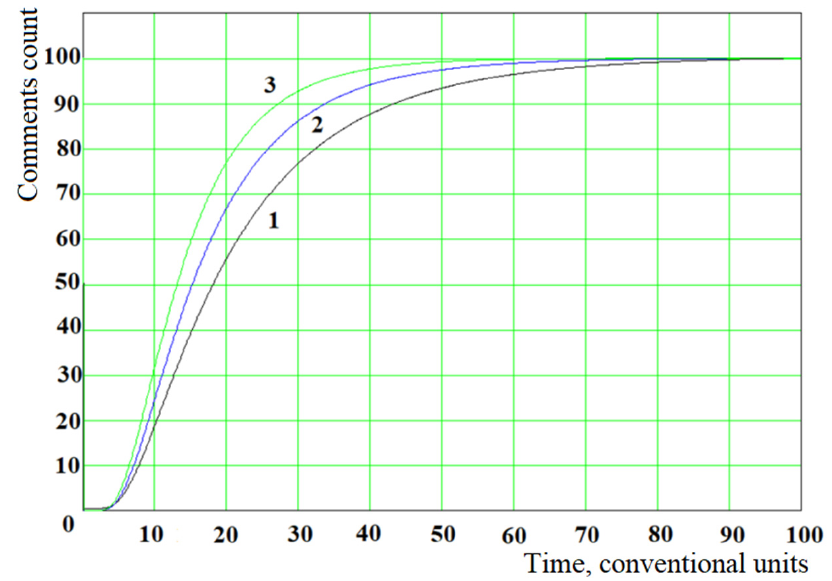
Figure 11. Dynamics of changes over time, the number of comments on a news item of public inter- est that appeared on the portal https://echo.msk.ru/news/2571431-echo.html, accessed on 15 January model based on the Fokker-Planck 2020, after removing the time gaps.